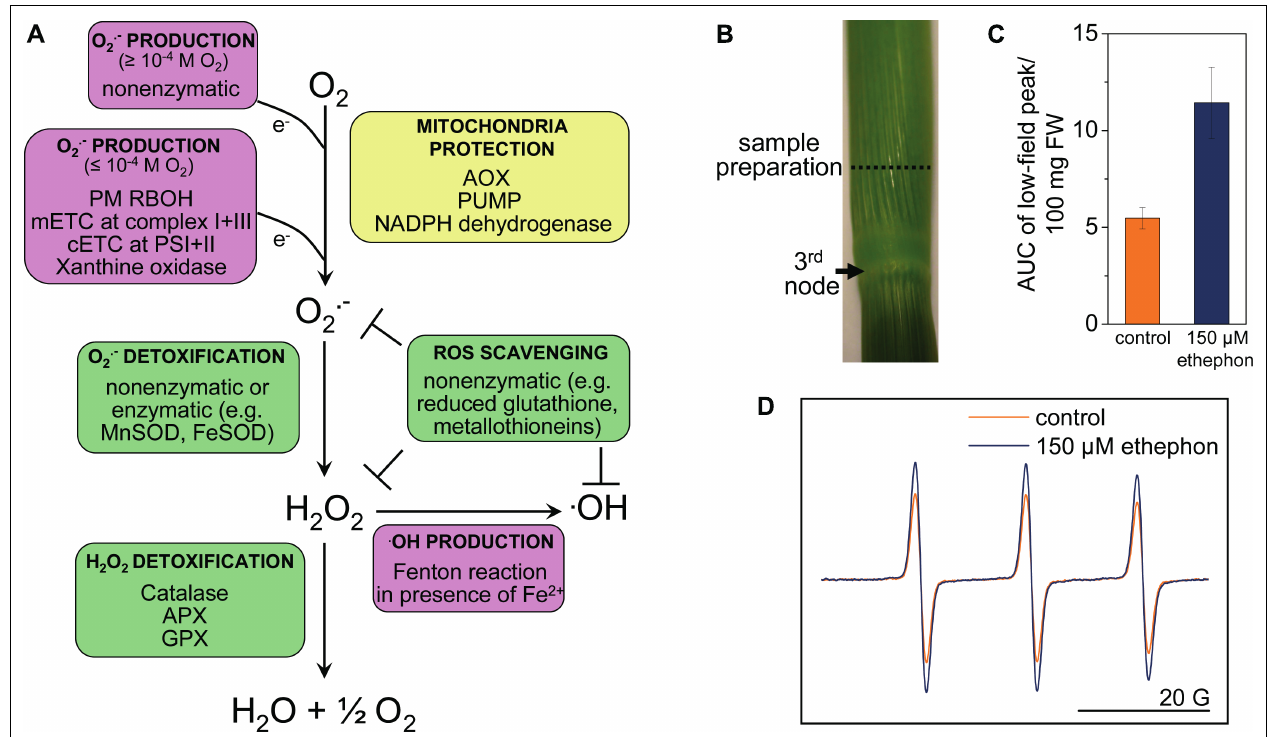
FIGURE 1 | Reactive oxygen species homeostasis in plants. (A) ROS are generated enzymatically or non-enzymatically depending on internal O 2 levels. In photosynthetic tissues, the main sources of ROS are the chloroplasts and peroxisomes (reviewed in Shapiguzov etal., 2012). In photosynthetically active chloroplasts, O •− 2 is generated at photosystems I and II. In the dark, at low light conditions or in photosynthetically inactive tissues ROS are produced mainly in mitochondria. O •− 2 is produced by the flavin mononucleotide binding subunit of NADH dehydrogenase in complex I and by ubiquinol-cytochrome bc1 reductase in complex III of the mitochondrial electron transport chain (mETC), or by RBOH at the plasma membrane. O •− 2 is dismutated to H 2 O 2 non-enzymatically, by a manganese-containing isoform of the superoxide dismutase (MnSOD) in the matrix (Møller, 2001), or by FeSOD in chloroplasts and Cu/ZnSOD in the cytosol. • OH is a highly reactive ROS that is produced in the Fenton reaction from H 2 O 2 in the presence of metals such as Fe 2 + .The uncoupling protein (PUMP), the alternative oxidase (AOX) and an alternative NAD(P)H dehydrogenase protect mitochondria from unwarranted ROS production. Antioxidants such as reduced glutathione,